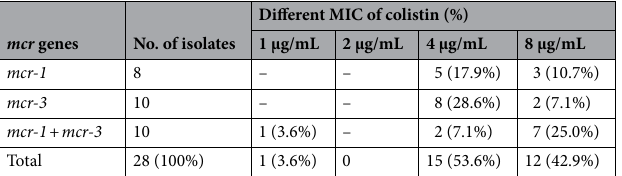
Table 3. The distribution of E. coli strains (N = 28/37) harboring colistin-resistance genes at different MICs of